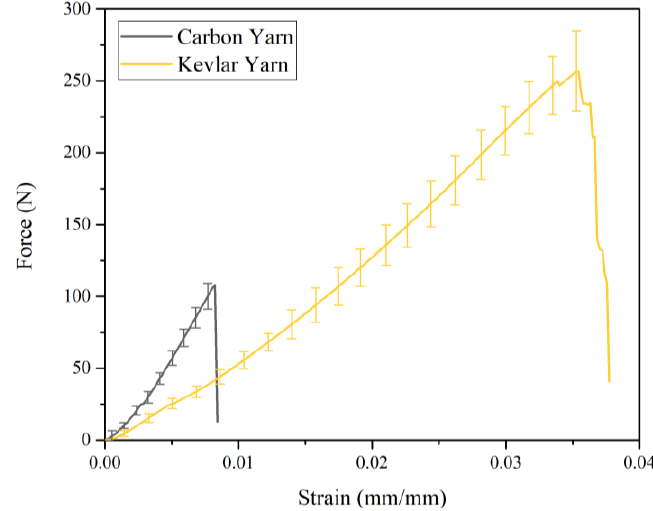
Figure 7. Tensile force versus strain curves of carbon yarn and Kevlar yarn at a loading speed of 10 mm/min.